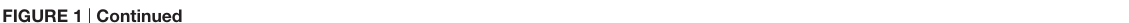
FigUre 1 | continued One example slice and low-Mg 2 + -induced epileptiform discharges . (a) An image of a hippocampal slice mounted on micro-electrode array (MEA). The black dots stand for the electrodes, with electrode number labeled at its top left corner. The slice is composed of the hippocampus proper (DG, CA3a/b/c, CA1) and the subiculum (Sub). (B,c) Low-Mg 2 + -induced interictal-like discharges (IIDs) (B) and ictal-like discharges (IDs) (c) recorded by the MEA. Each window represents the recording from one electrode, with each electrode number labeled at its top right corner. (D) The upper trace exhibits a period ( − 2,100 s) of data recorded by one electrode (number 27) in (a) , which represents four discharge cycles in the CA3. The middle trace displays one of the four discharge cycles in the upper trace in an expanded time scale, which consists of six IIDs (*) and one ID ( → ). The lower trace further shows one IID and the ID in the middle trace in a more expanded time